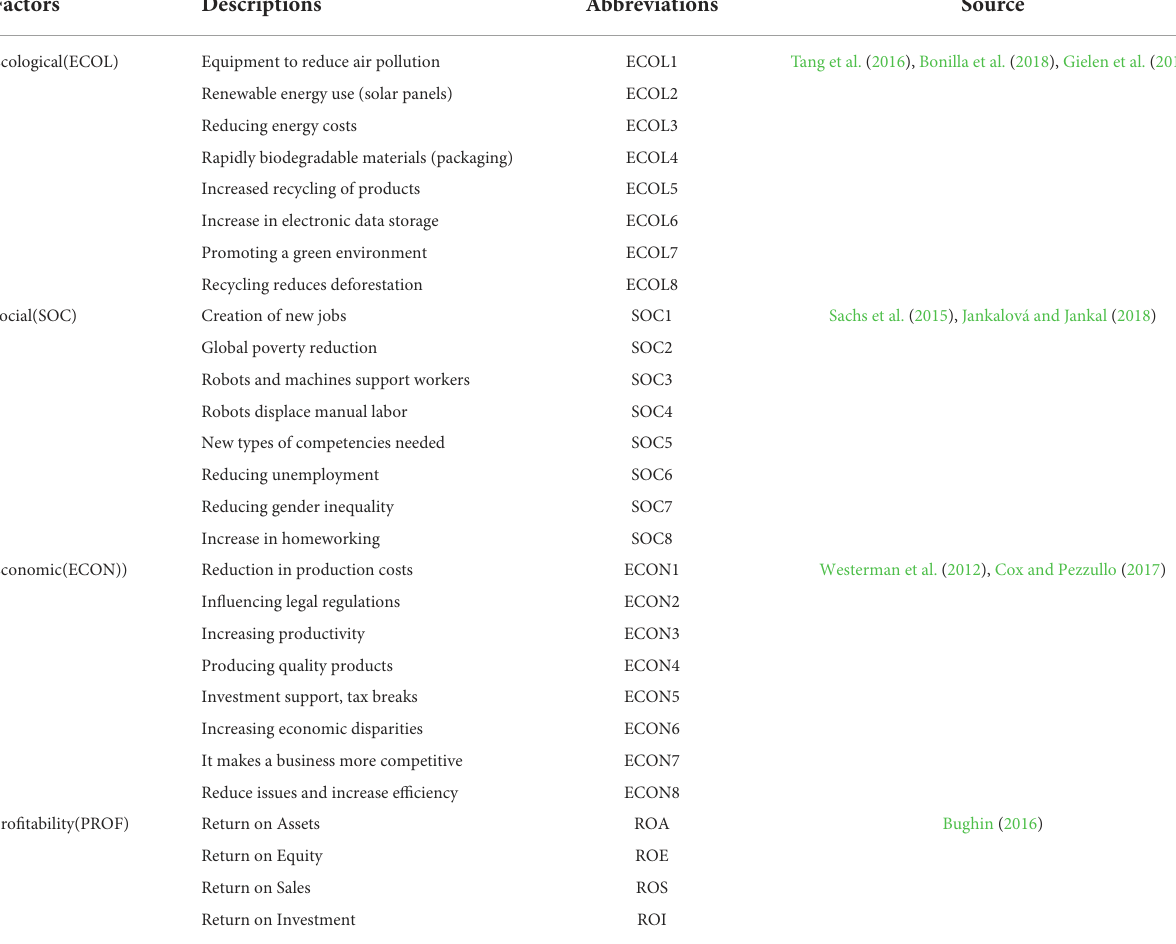
TABLE 2 Sources and abbreviations of sustainable development items and profitability